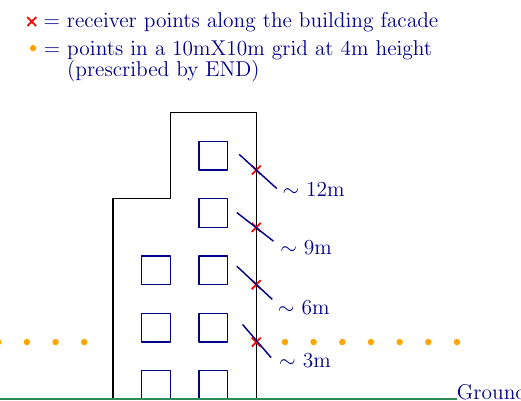
Figure 4: Placement of noise calculation points along the building facade and in a grid